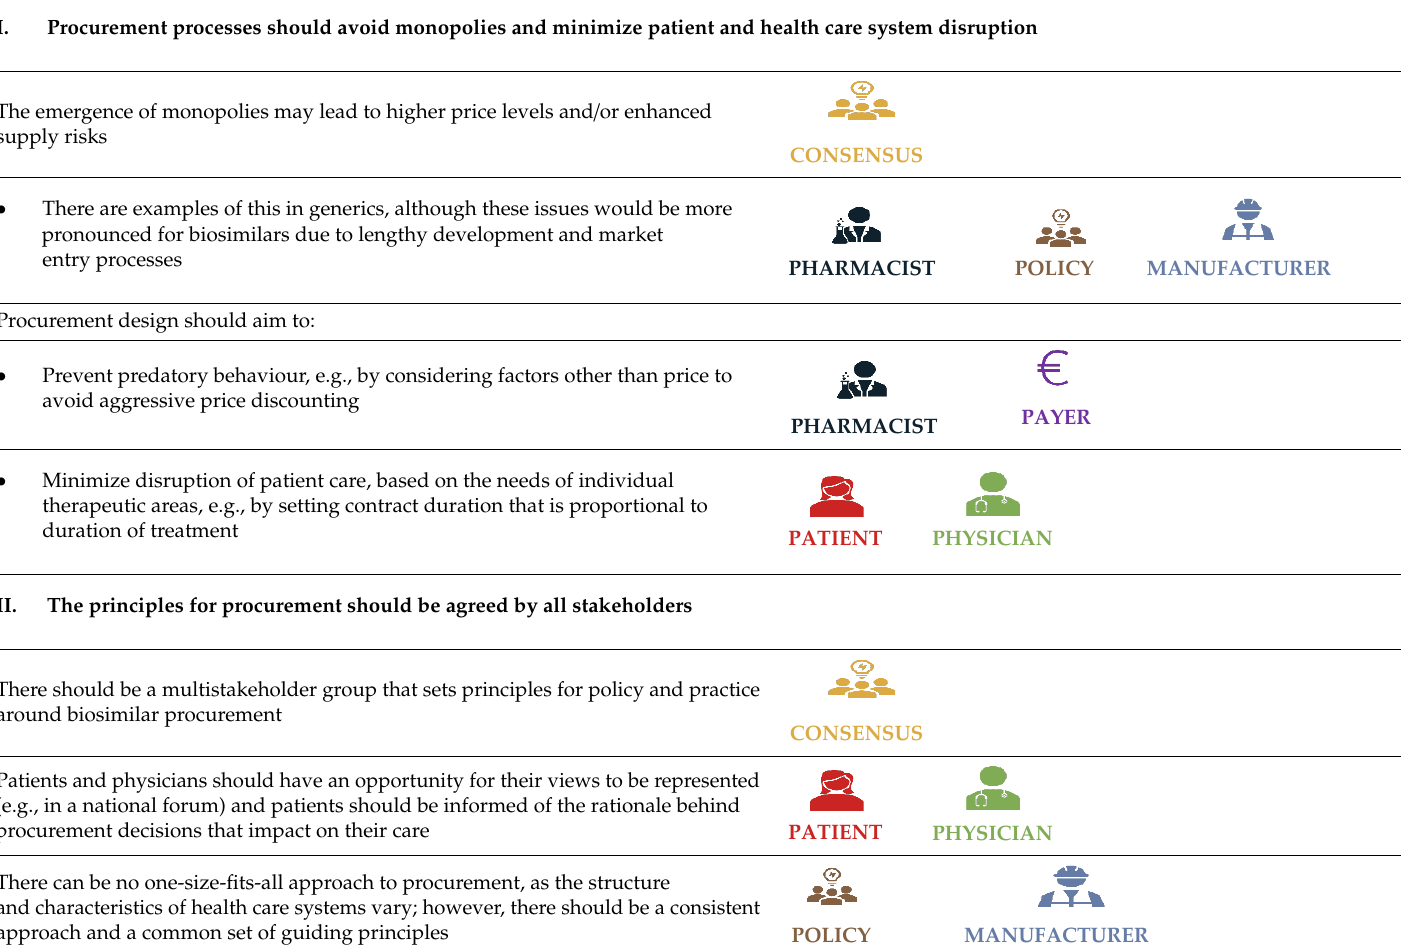
Table 1. Consensus on components of a sustainable biosimilar market.